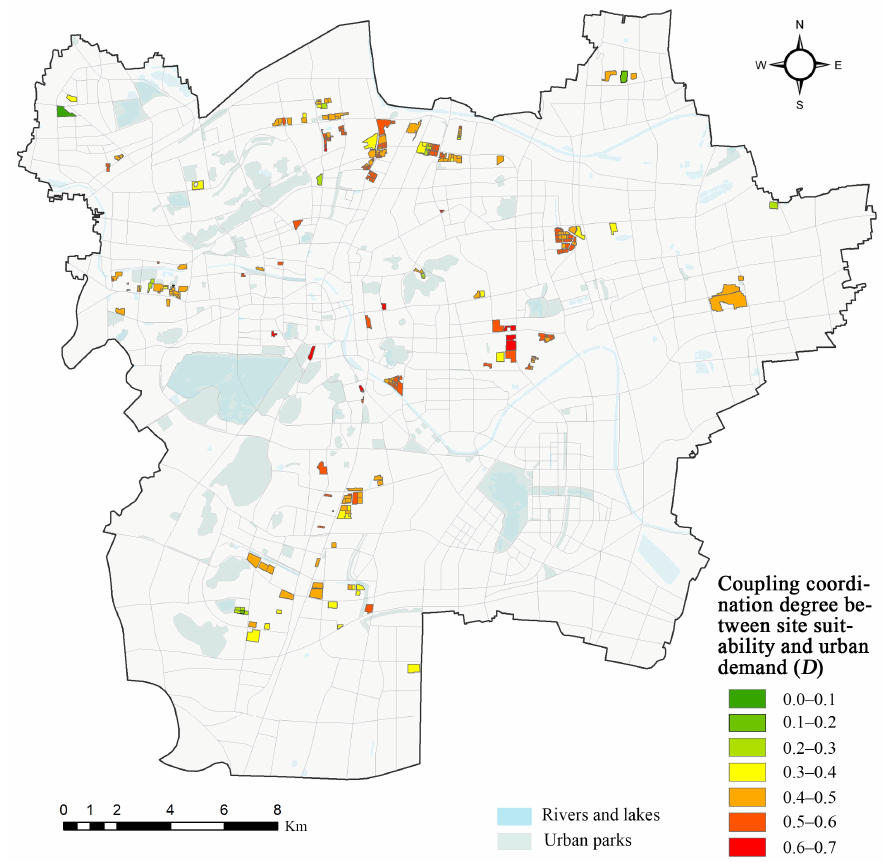
Figure 7. Coupling coordination degree between site suitability and urban demand.